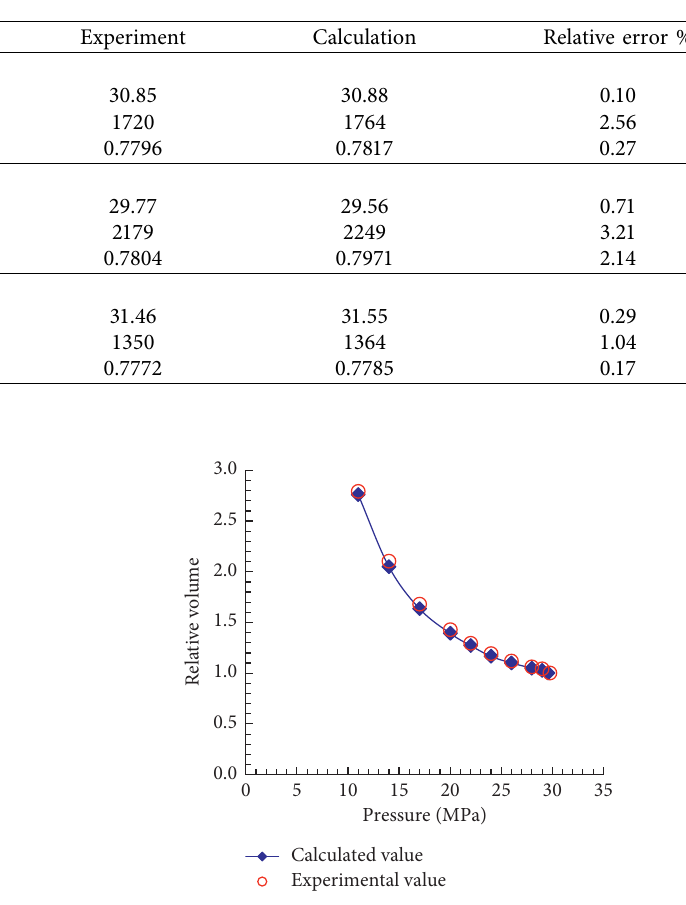
Figure 8: Comparison for sample 2 of calculated and experimental relationship diagram between relative volume and pressure.